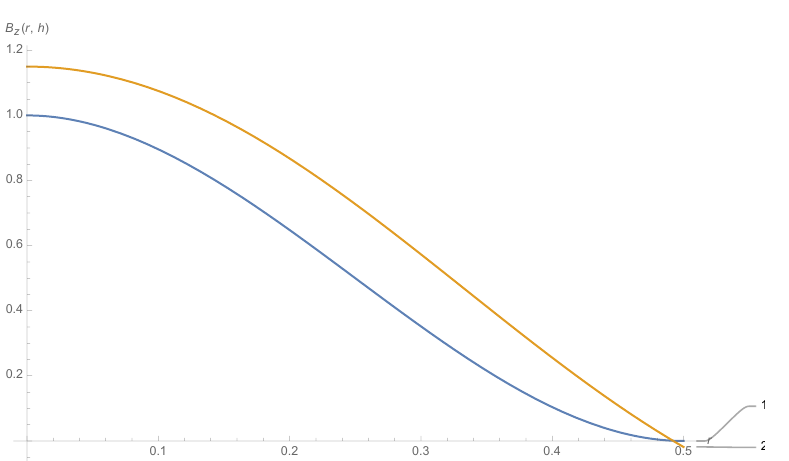
Figure 1. B z -component of the magnetic field as a function of the radius r . The blue curve (curve 1) represents B z ( r , z = h ) as in [12], and the yellow curve (curve 2) is the approximation of B z ( r , h ) of Equation (18) with the Bessel function J 0 ( x 02 r ) + 0.15 (see Equation